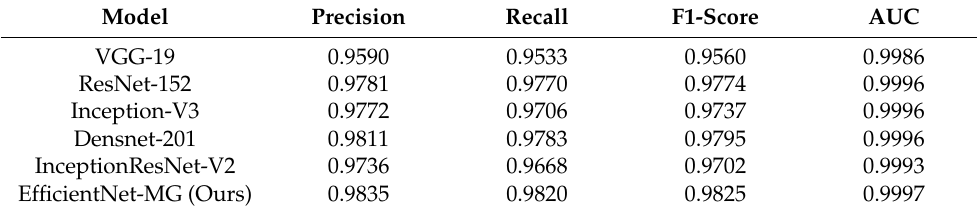
Figure 14. Performance of different models. Table 6. Identification performance comparison among different CNN models.